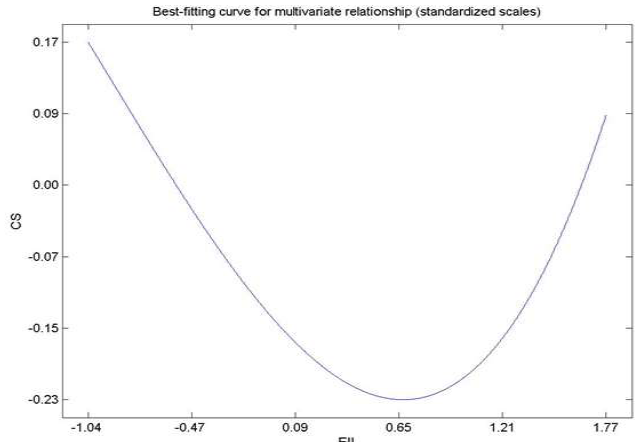
Fig. 3. Non-linear (U-curve) relationship EII to